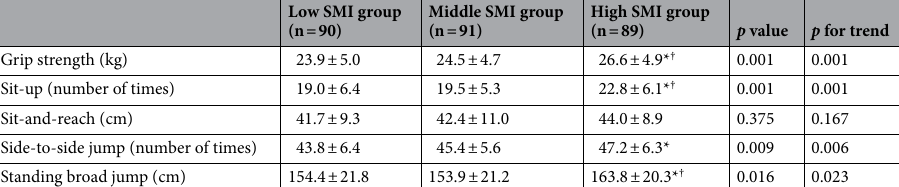
Low SMI group (n =